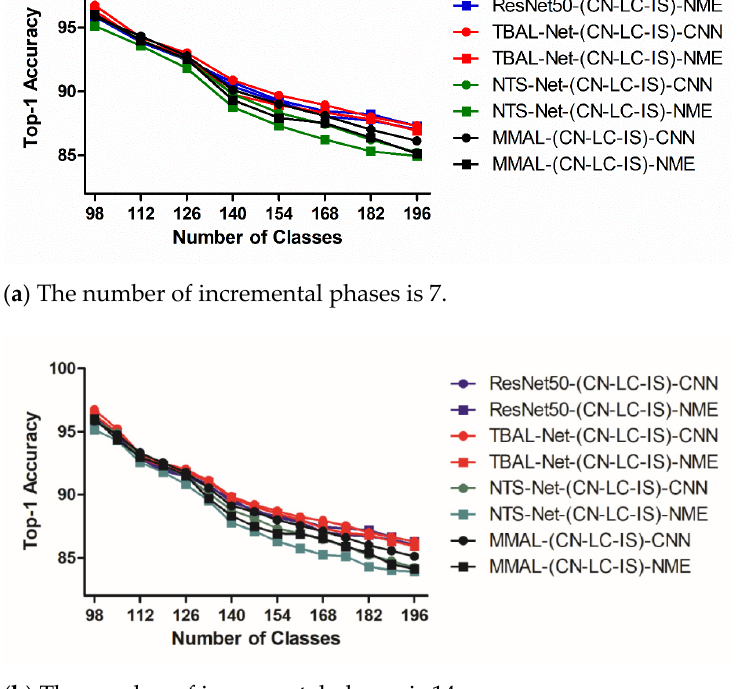
Figure 6. The performance of different number of incremental phases on Stanford-Car.